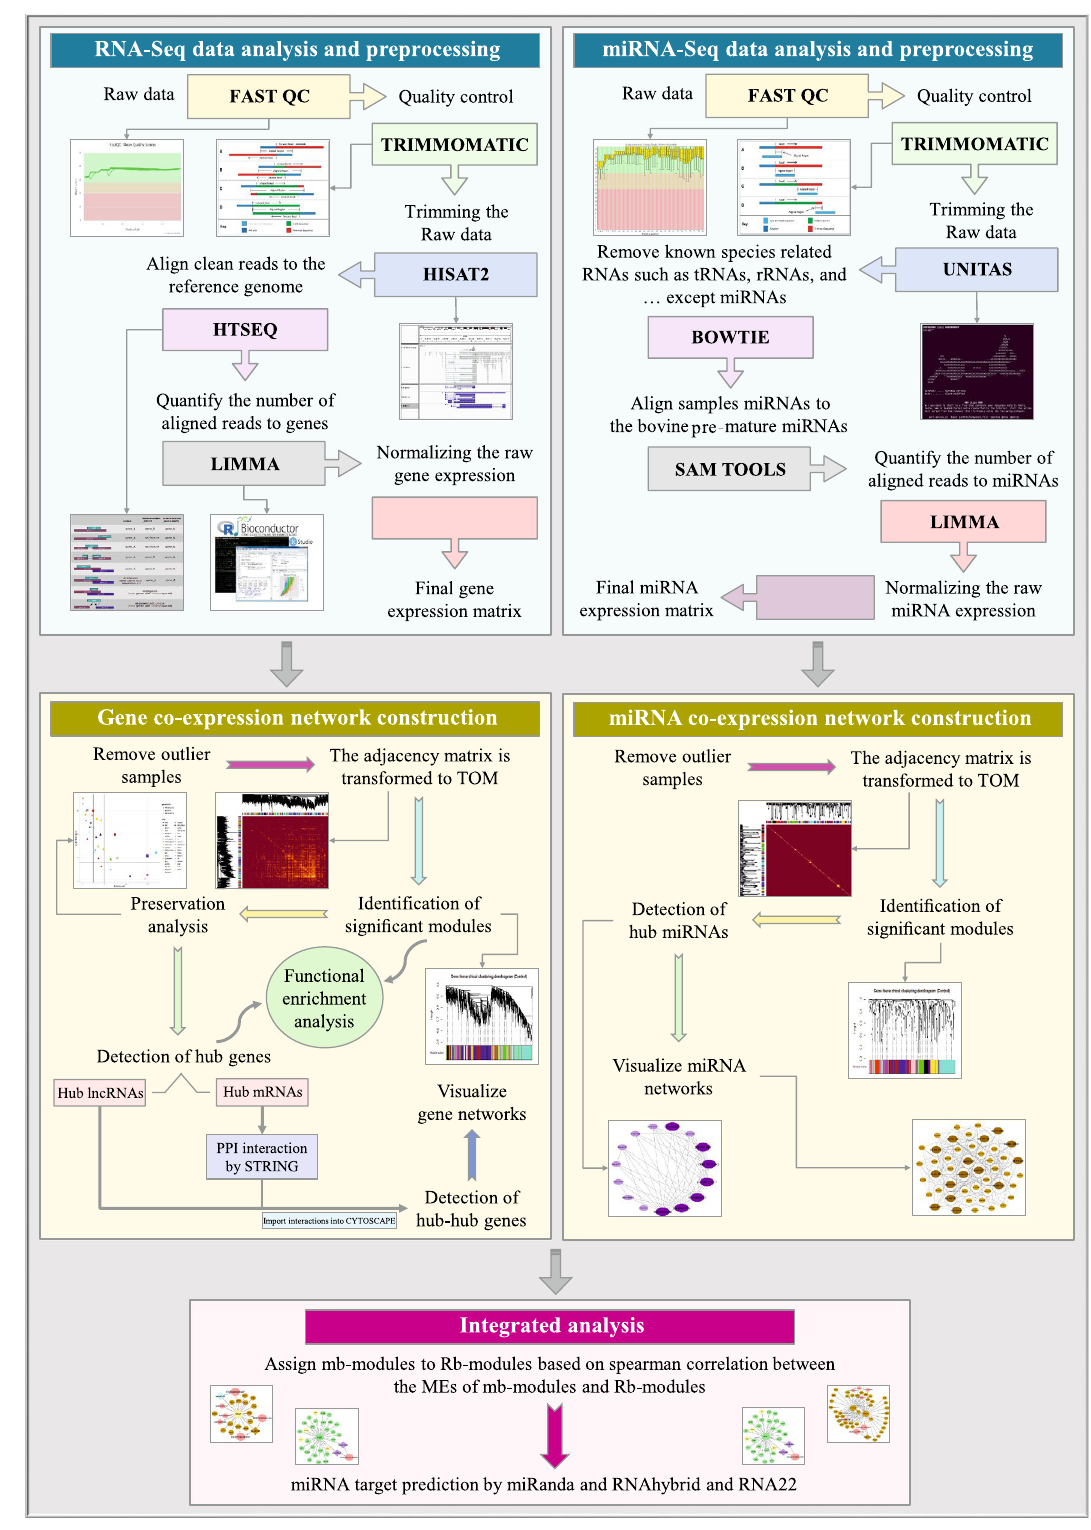
Figure 1. The used pipeline for constructing the integrated regulatory